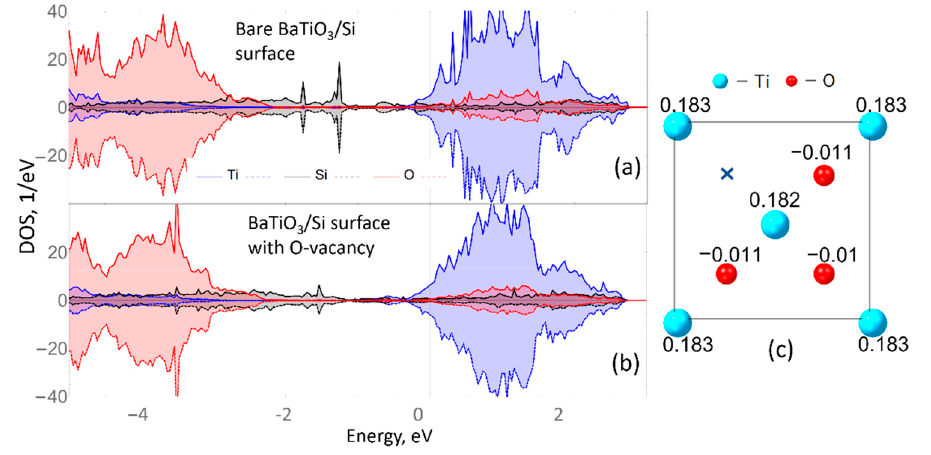
Figure 5. ( a ) Spin-polarized DOS spectra for bare BTO/Si and with ( b ) oxygen vacancy. ( c ) Top view on the surface TiO 2 layer of the BTO/Si heterostructure with O-vacancy with denoted magnetic moments per atom in μ B .